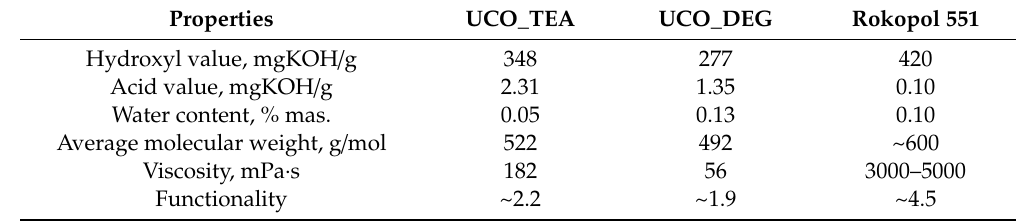
Table 1. Characteristics of the bio-polyols and petrochemical